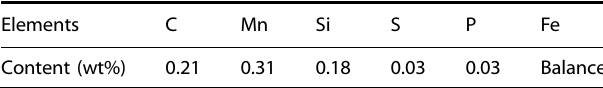
Table 2. Chemical composition of Q235 carbon steel